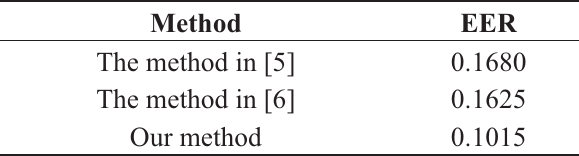
Table 3. The performance of finger vein identification on subdatabase by different ROI localization